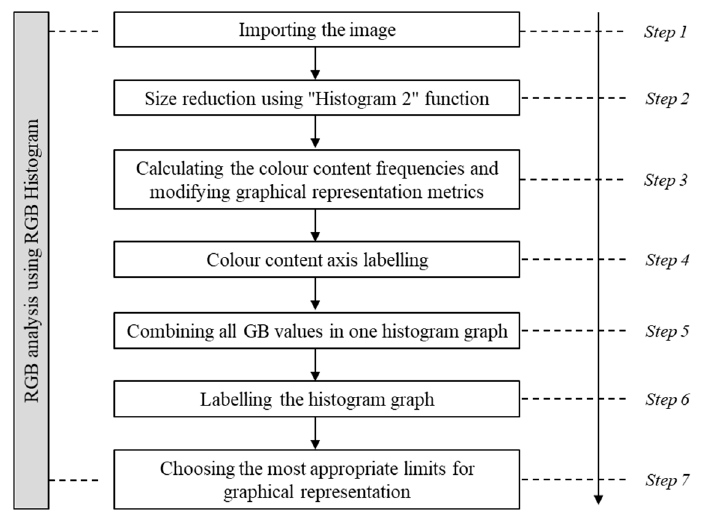
Figure 5. The steps needed to perform the RGB bivariate histogram analysis and display. Each picture contains 65,025 pixels with each pixel having a value for red, green, and blue. The steps needed to perform the RGB bivariate histogram analysis are shown in Figure 5. In this technique, the outcome can be exported in multiple CSV formats including the colour content data, jpeg formatted graphs representing two colours juxtaposed to each other, and a graphical representation of the colour content measured by frequencies and intensity (Figures 6 and 7).